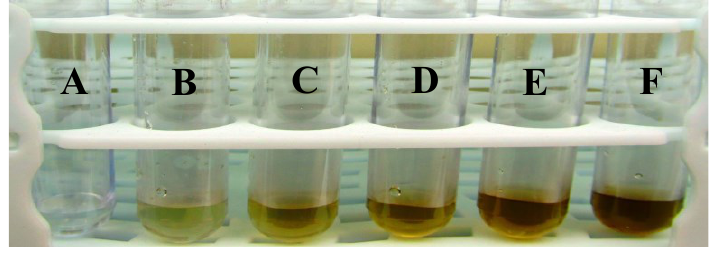
Figure 1. Visual appearance of vials containing A: Ag + 5 mM; B: Flower extract A. biebersteinii ; C: Ag + /A after 60 min; D: Ag + /A after 90 min; E: Ag + /A after 120 min; F: Ag + /A after 180 min.